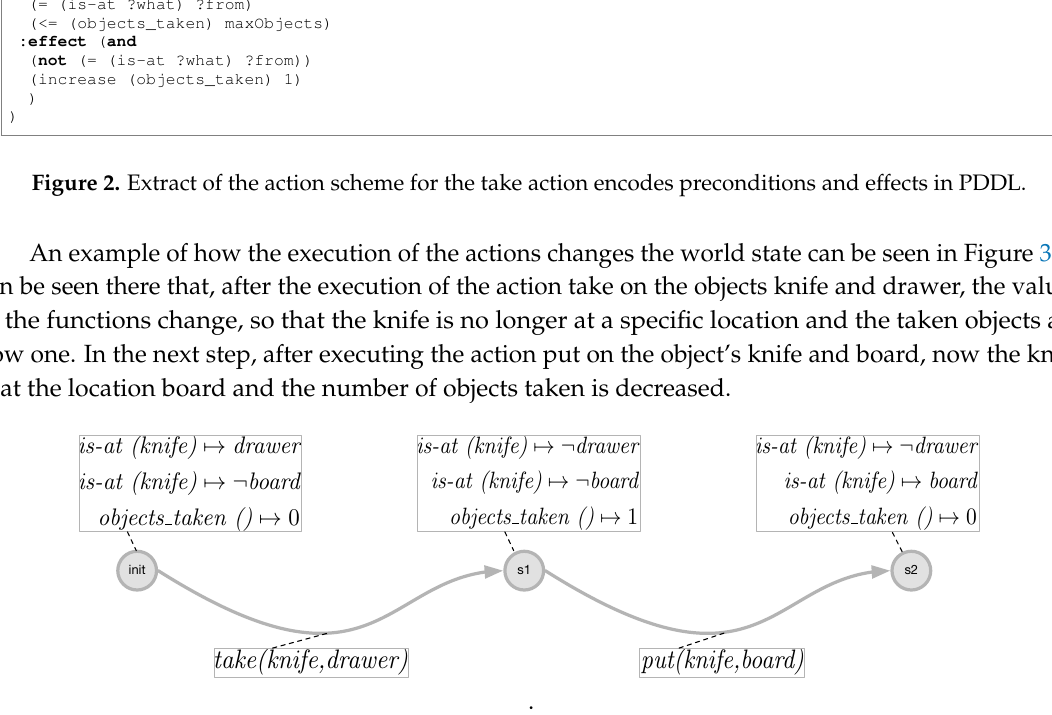
Figure 3. Change in the values of the functions and thus in the state space after the execution of the actions take and put.